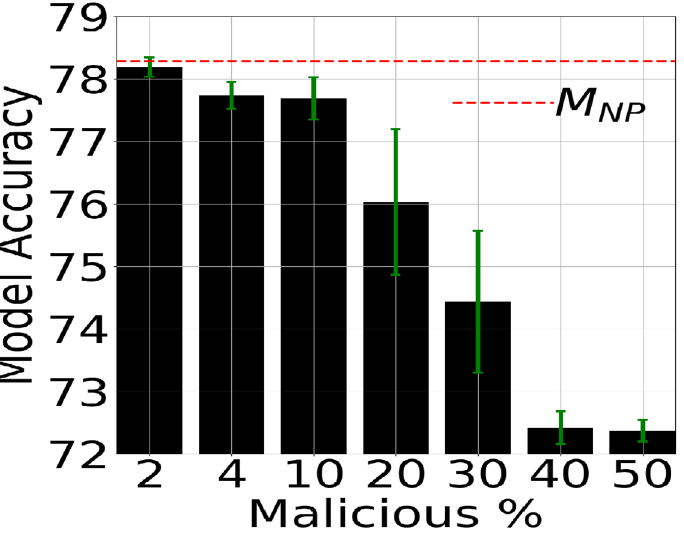
Figure 6. Attack visibility and impact of malicious nodes on a conventional FL system.